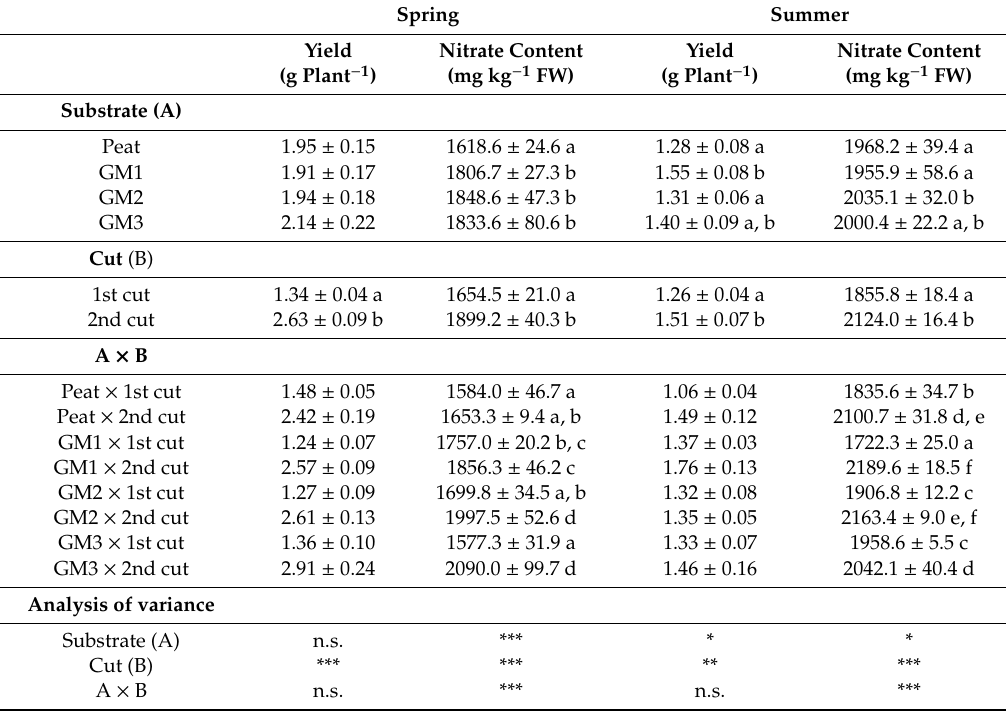
Table 4. Yield and nitrate content in baby leaf red lettuce grown on di ff erent growing media (peat, GM1, GM2, GM3) in a floating